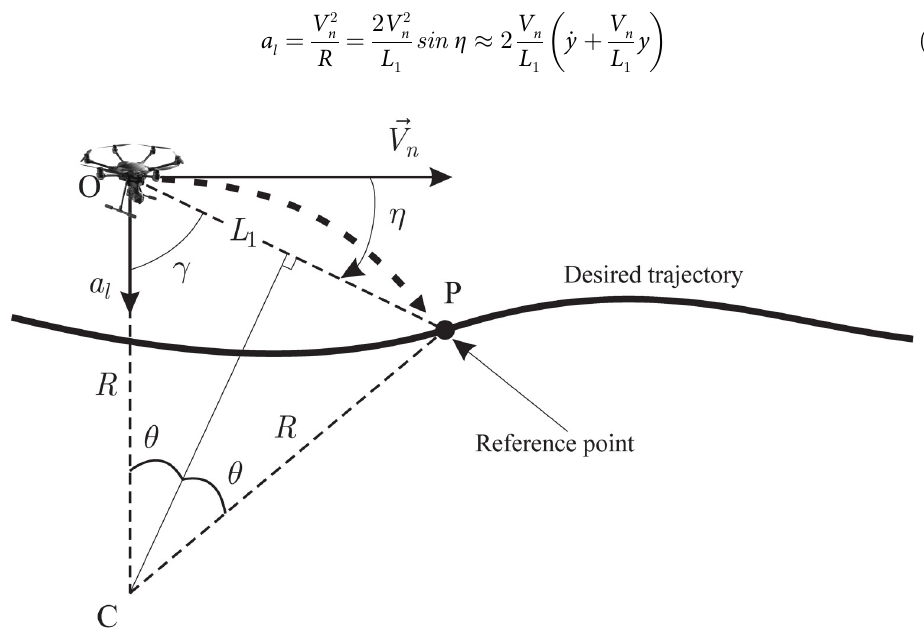
Fig 11. Circular trajectory calculated for lateral